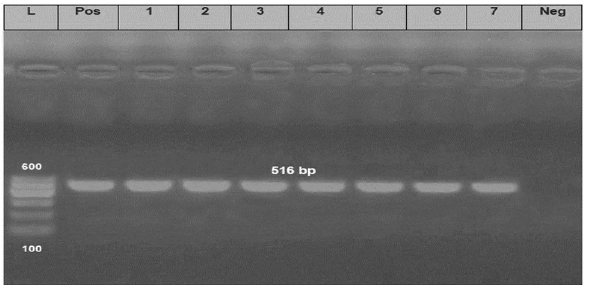
Figure 7. Electrophoretic pattern of primers targeting bla TEM gene. Lane L: 100 bp molecular weight ladder (Fermentas, Thermo Scientific, Germany); lane Pos: the positive control (Reference strain from Animal Health Research Institute in Dokki, Cairo, Egypt), and lane Neg: the negative control (template without DNA). Lanes 1–7: the specific DNA product (516 bp) amplified from representative isolates of P. aeruginosa .